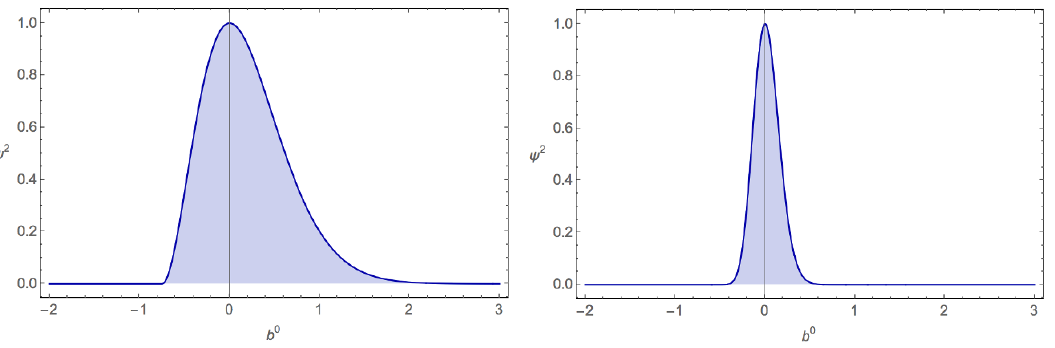
Figure 4 . Wave function squared j ~ 0 ( b 0 ) j 2 for N = 2 (left) and N = 20 (right). The positivity constraint on H = D + B restricts b 0 > (cid:0) 3 , unlike in the naive version shown in (cid:12)gure 4